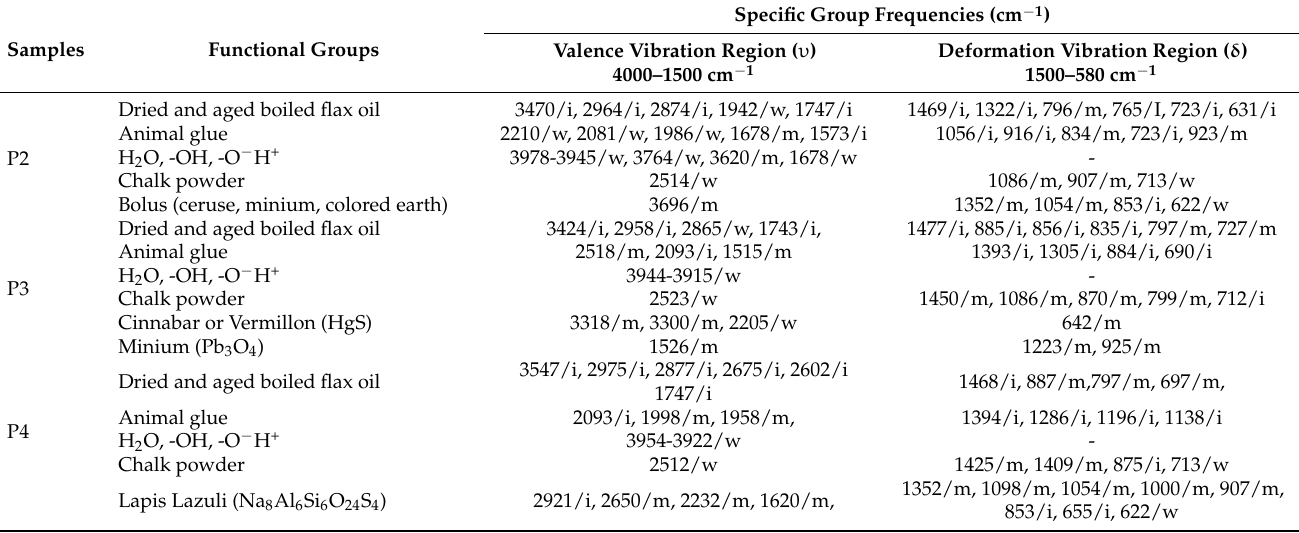
Table 2. Specific group vibration values of the bands for the three samples of pictorial material (preparation-P2, red pigment-P3 and blue